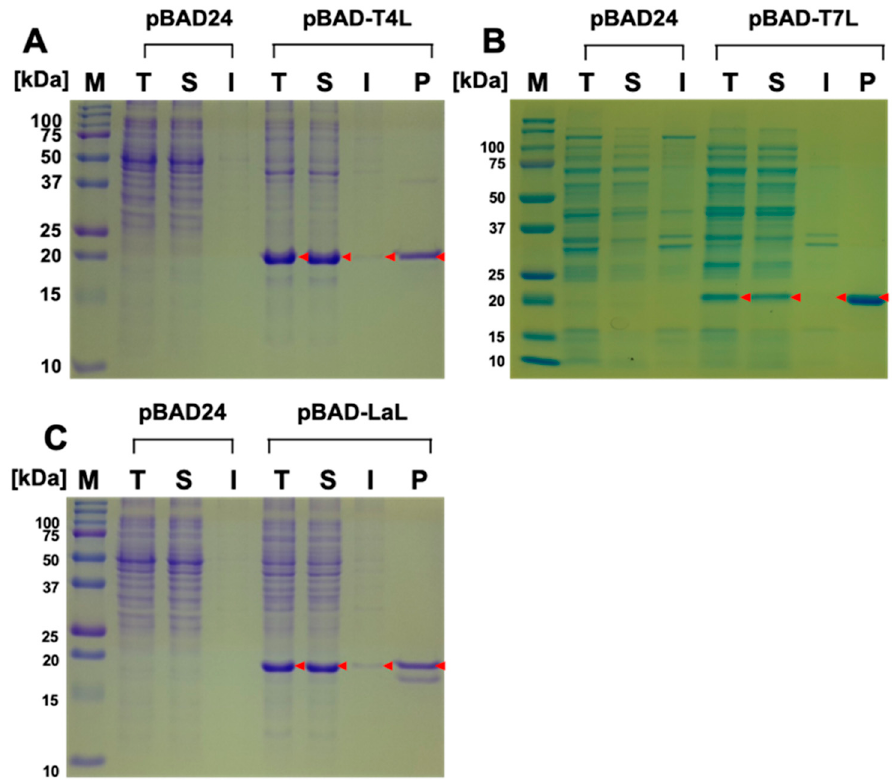
Figure 1. Expression and purification of bacteriophage T4 lysozymes. Escherichia coli LMG194 strain harboring the pBAD24 (negative control), (A) pBAD-T4L (T4 lysozyme), (B) pBAD-T7L, or (C) pBAD-LaL (lambda lysozyme) plasmid were cultivated at 37 ºC for 4 hours after the addition of 2 g / L of L-arabinose. Lane M: standard marker protein; T, total cell lysate; S, soluble fraction; I, insoluble fraction; P, purified proteins.